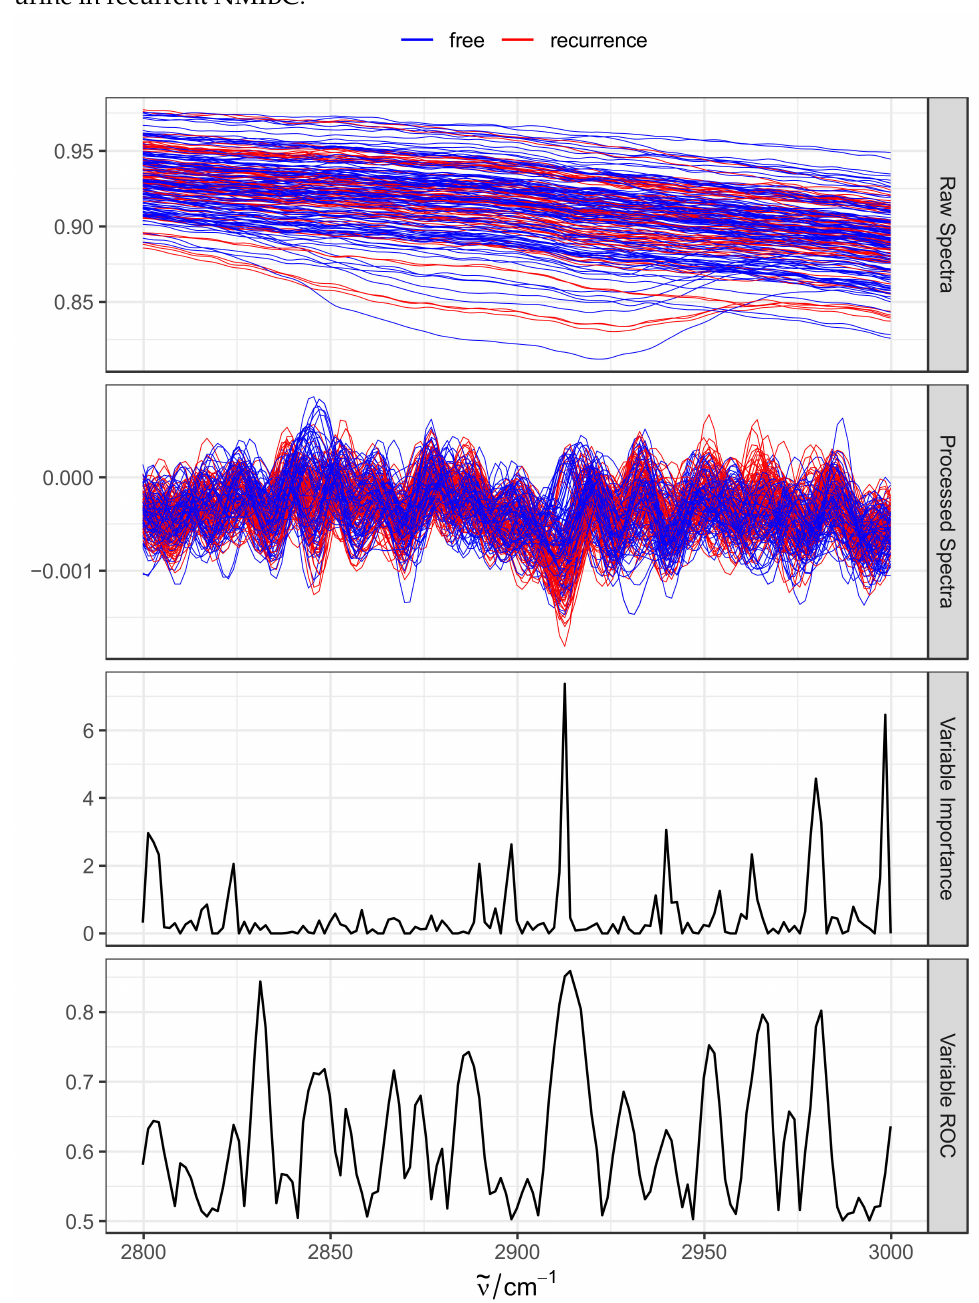
Figure 5. Investigation of wavenumber ranges contributing to model performance. Raw and pro- cessed spectra for the selected spectrum range (top two panels) are shown, colored by NMIBC status. Variable importance scores (third panel) are directly obtained from the model using out-of-bag estimation strategy. Variable ROC scores are obtained via similar strategy but evaluating estimates against the test